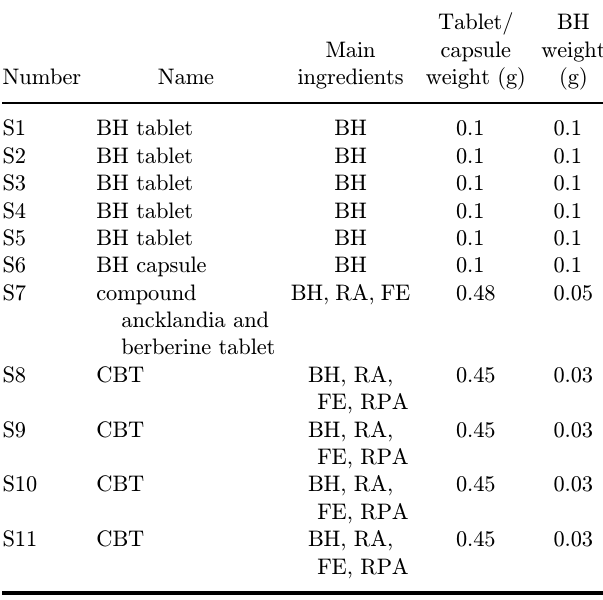
Table 2. 11 types of CPM samples from di®erent